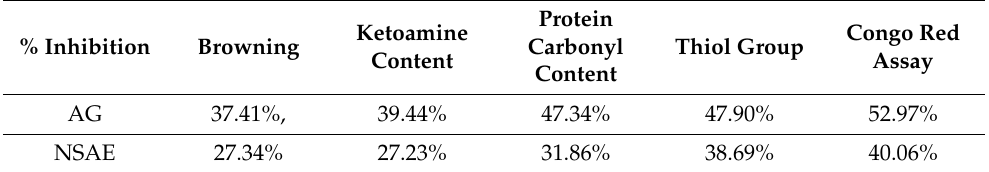
Figure 4. The effect of NSAE on browning reaction in BSA+D-ribose system. B-BSA, B+R=BSA+Ribose, B+NSAE=BSA+ Nigella sativa aqueous extract, and B+R+NSAE= BSA+Ribose+ Nigella sativa aqueous extract. Results are represented as mean ± SD ( n = 5). a p < 0.05 when compared to BSA and b p < 0.05 when compared to BSA+D-ribose. Table 2. The percentage inhibition of AG and NSAE on protein glycation and aggregation in the BSA+D-ribose system.